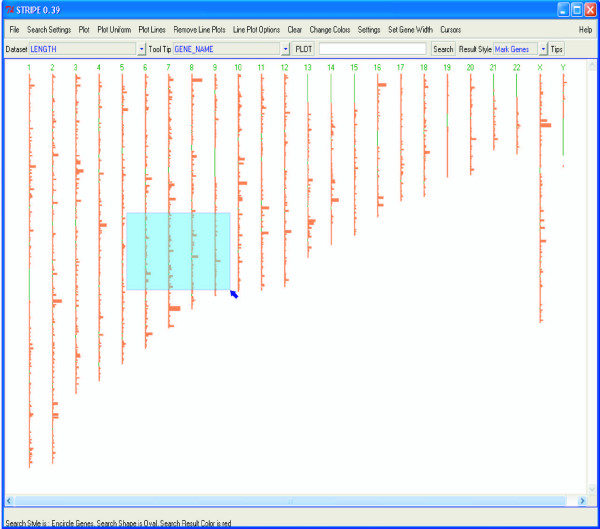
The figure shows all the genes in the human genome and their length plotted with STRIPE. Similar plots can be created immediately for the mouse and the rat genome by selecting a pre-prepared file. The blue colored box represents a selected region of interest. The data plotted in the figure is the gene lengths of all genes in the human genome. Longer genes appear thicker than shorter genes, as the lengths are scaled to size both along the vertical chromosome and the horizontal axis.